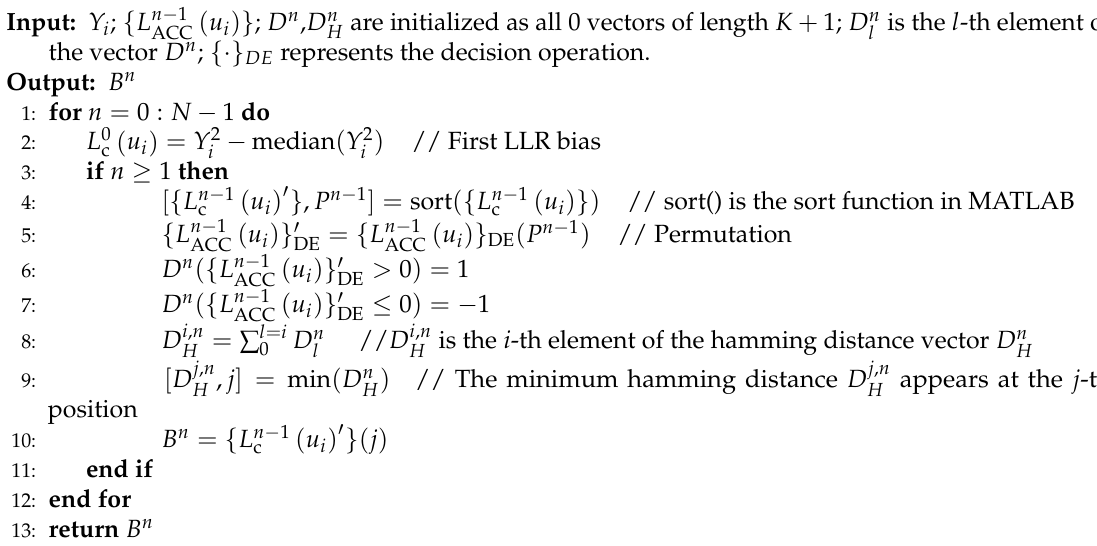
Algorithm 1 Search Algorithm of